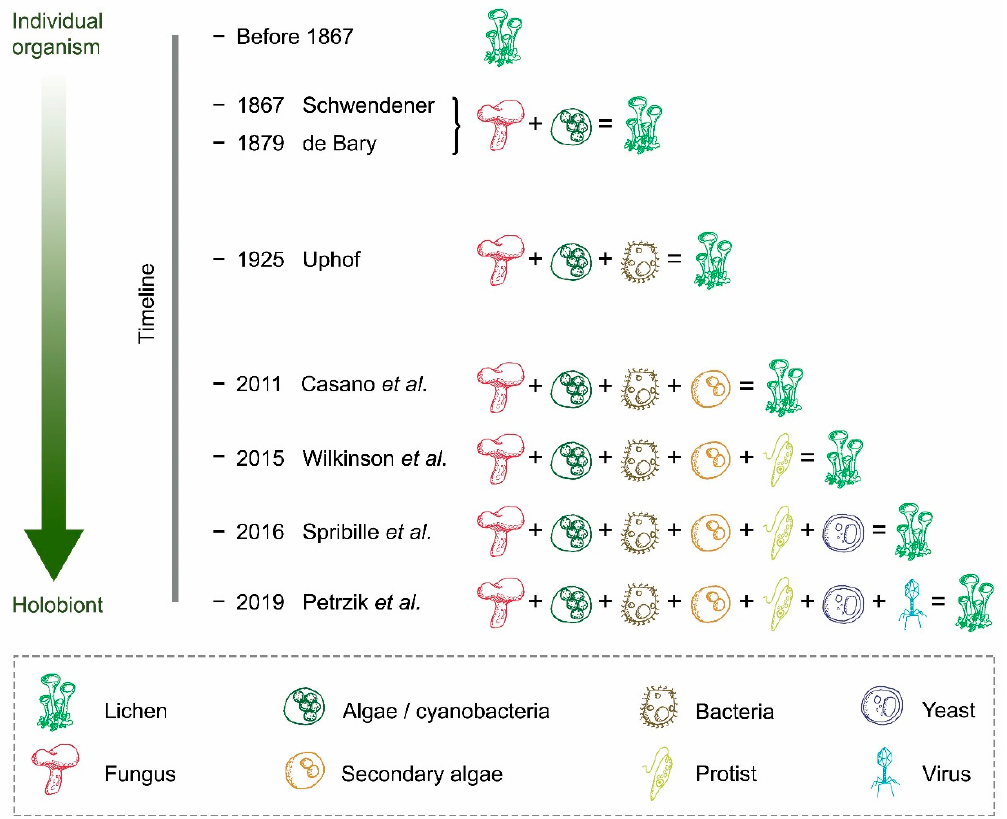
Figure 2. Temporal line indicating the timing at which the different components of the lichen partnership were discovered. This figure reflects the journey from considering lichens as a single organism to the complex multipartner symbiotic relationship known nowadays